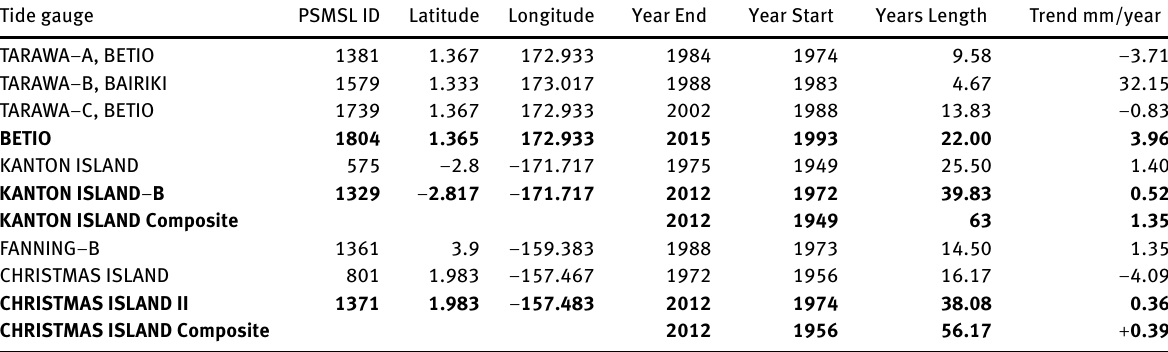
Table 1: Analysis of all the tide gauges of Kiribati in the PSMSL data base (data from [10]). Tide gauge PSMSL ID Latitude Longitude Year End